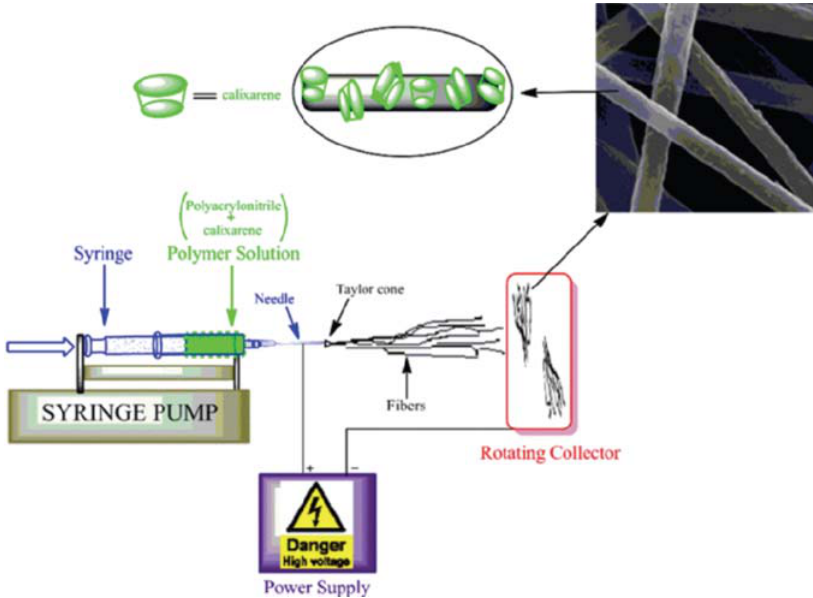
Figure 2. A setup for the electrospinning process of calixarene compounds ( 3 ),( 5 ) and polyacrylonitrile